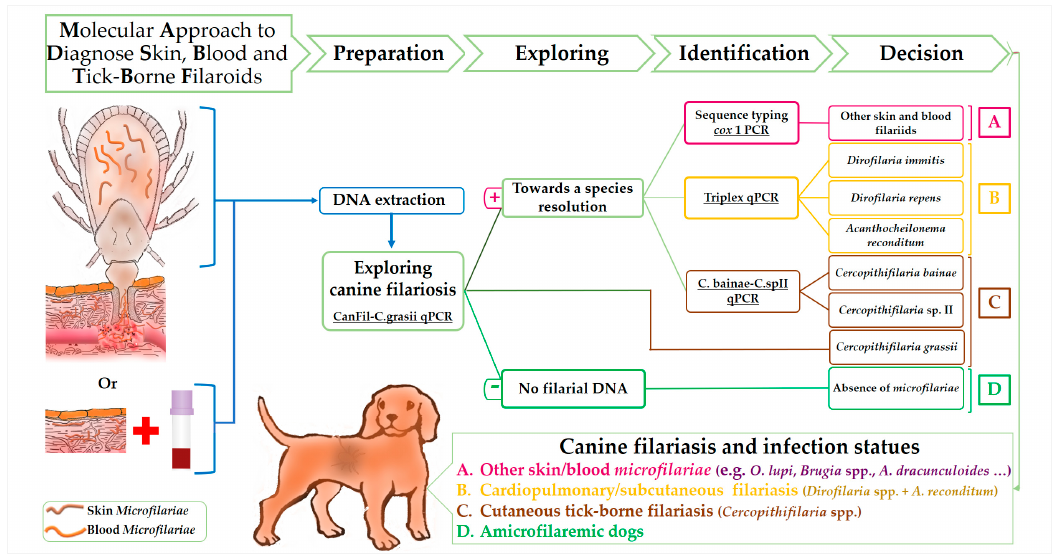
Figure 1. Flow Diagram showing the specificity-based principles of the proposed molecular approach in detecting canine filaroids.